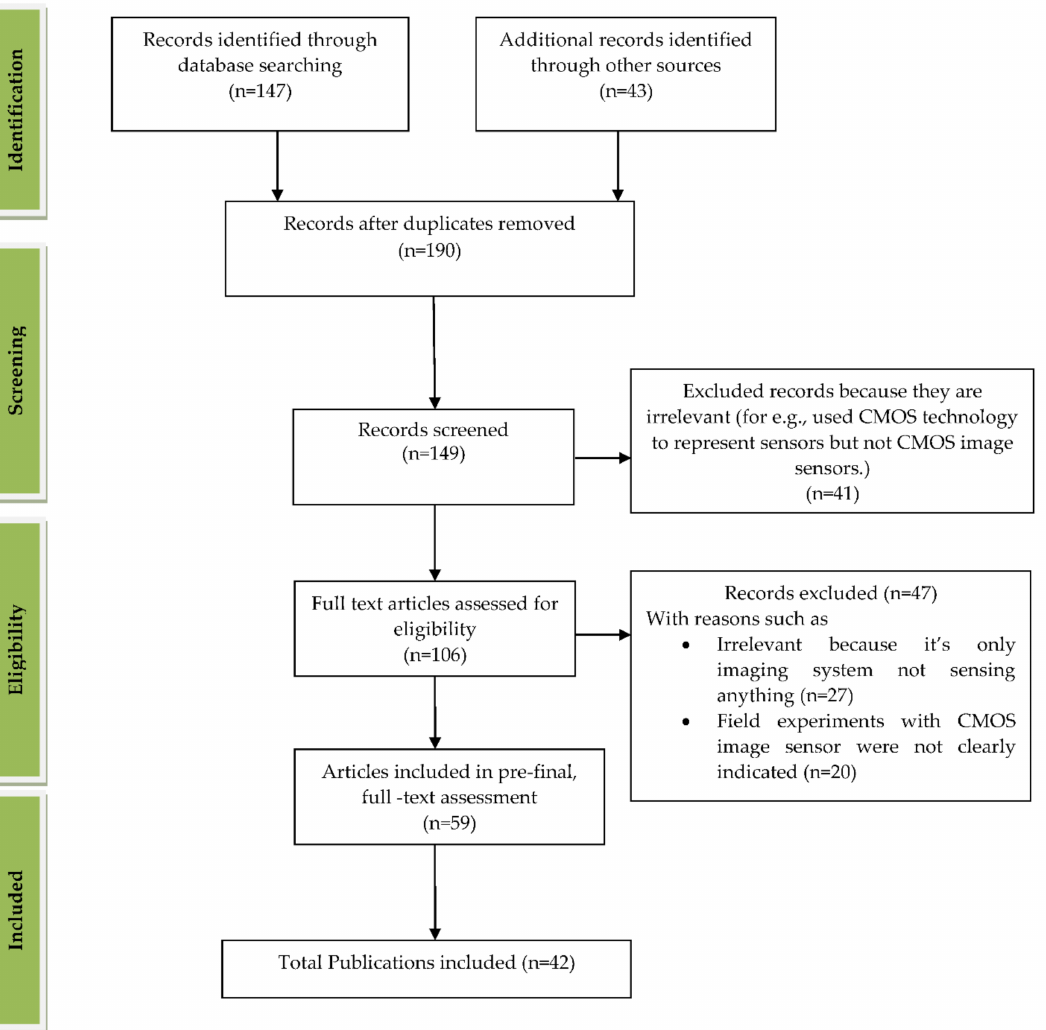
Figure 2. PRISMA workflow for the process of article selection. Figure adapted with permission from